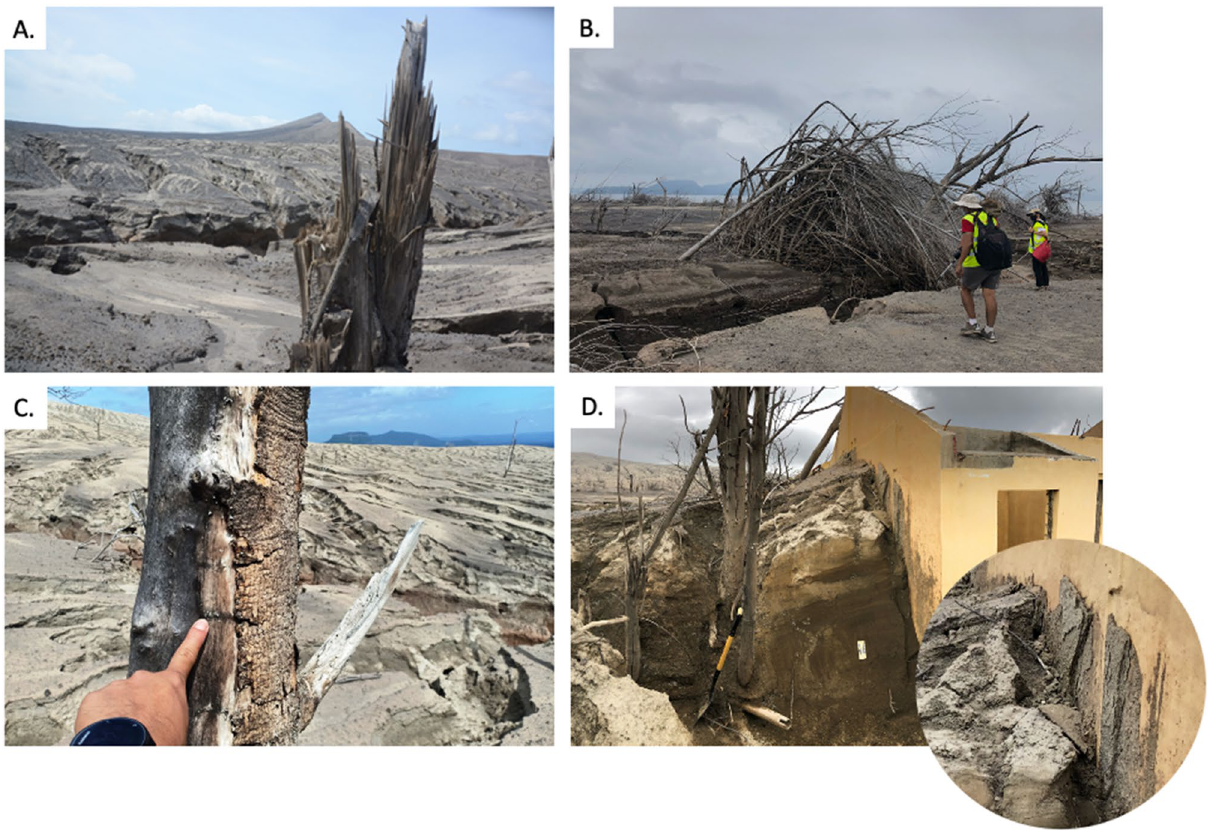
Figure 6. Photos of the effect of base surges on the southeast portion of TVI. ( A ) Snapped and splintered tree trunk of Ceiba pentrada with trunk diameter ~ 0.5 m; ( B ) Ruptured bamboo (Culm diameter = 12 cm); ( C ) Scorched and debarked tree on the side facing the crater; ( D ) Base surge deposit run-up against school wall facing the crater. Inset photo shows plastered base surge deposits. This unique feature of pasty materials persistently sticking on walls is proposed to be called